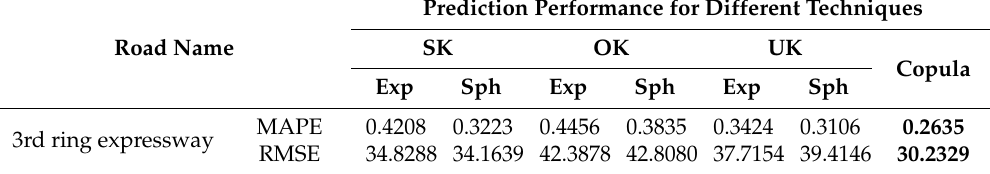
Table 10. Comparison between copula and kriging with MR at 17:00 on 7 June 2015.